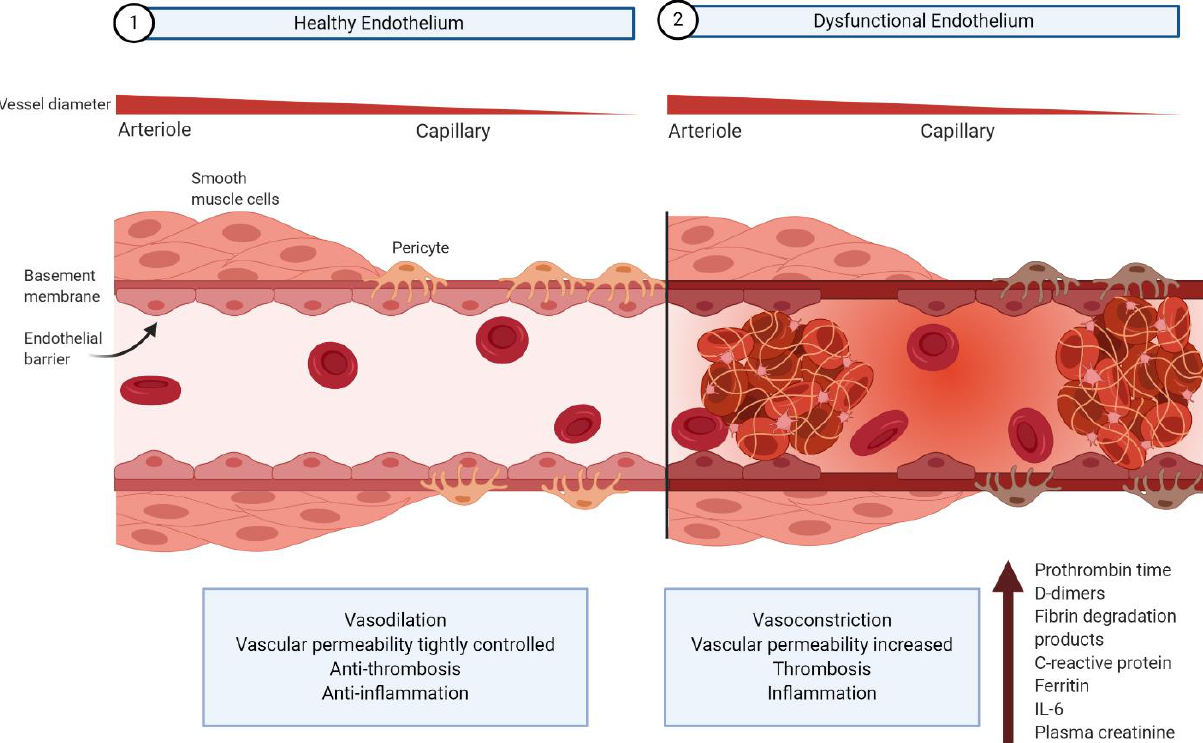
Figure 1. Architecture of healthy and dysfunctional vascular endothelium. (1) In homeostatic conditions, a healthy endothelium is a thin monolayer of endothelial cells at the interface between the circulation and tissue. A basement membrane separates the endothelium from smooth muscle and underlying connective tissue in arterioles. Smooth muscle cells regulate vascular tone, promoting vasodilation in conjunction with endothelial cells. As the vessel diameter decreases in capillaries, the vessel walls consist uniquely of the endothelial monolayer, basement membrane, and pericytes within the basement membrane wrapping around the abluminal surface of endothelial cells. Functionally, pericyte–endothelial cell cross-talk is essential to maintain normal endothelial cell shape and function. Together, endothelial cells, smooth muscle cells, and pericytes promote vasodilation, limit vascular permeability, promote an anti-thrombotic state, and reduce hyperinflammation in healthy patients. (2) However, disruption of the endothelial barrier and endothelial cell function leads to deleterious vasoconstriction, increased vascular permeability, thrombosis, and hyperinflammation. Dysfunction of the endothelium is indicated by a variety of biomarkers.